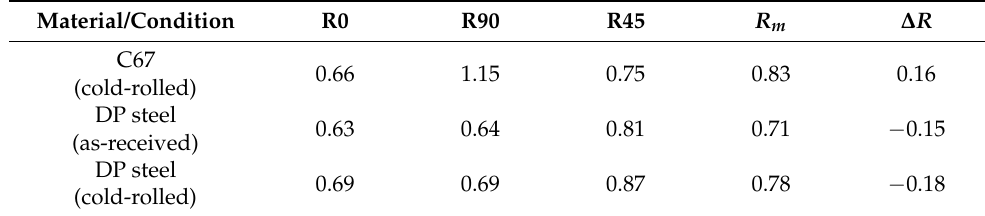
Table 2. Normal ( R m ) and planar ( ∆ R ) anisotropy, as calculated on broken tensile samples.